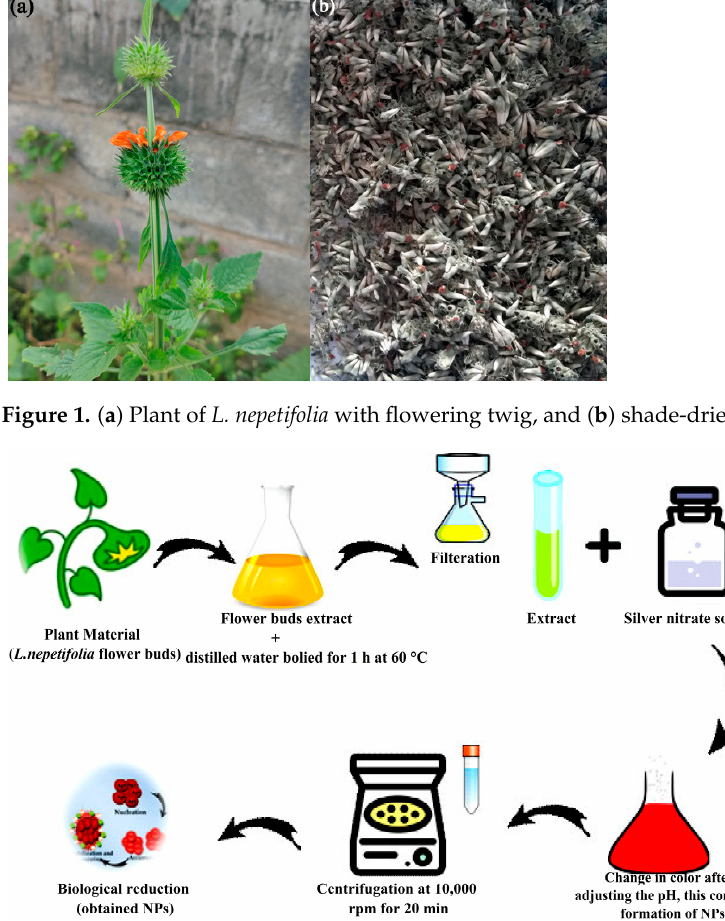
Figure 1. ( a ) Plant of L. nepetifolia with flowering twig, and ( b ) shade-dried flower buds.